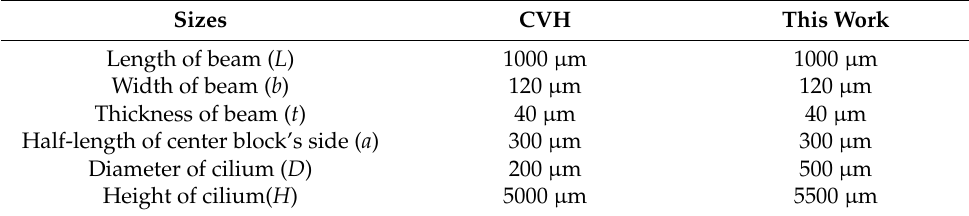
Table 1. Sizes comparison between the two